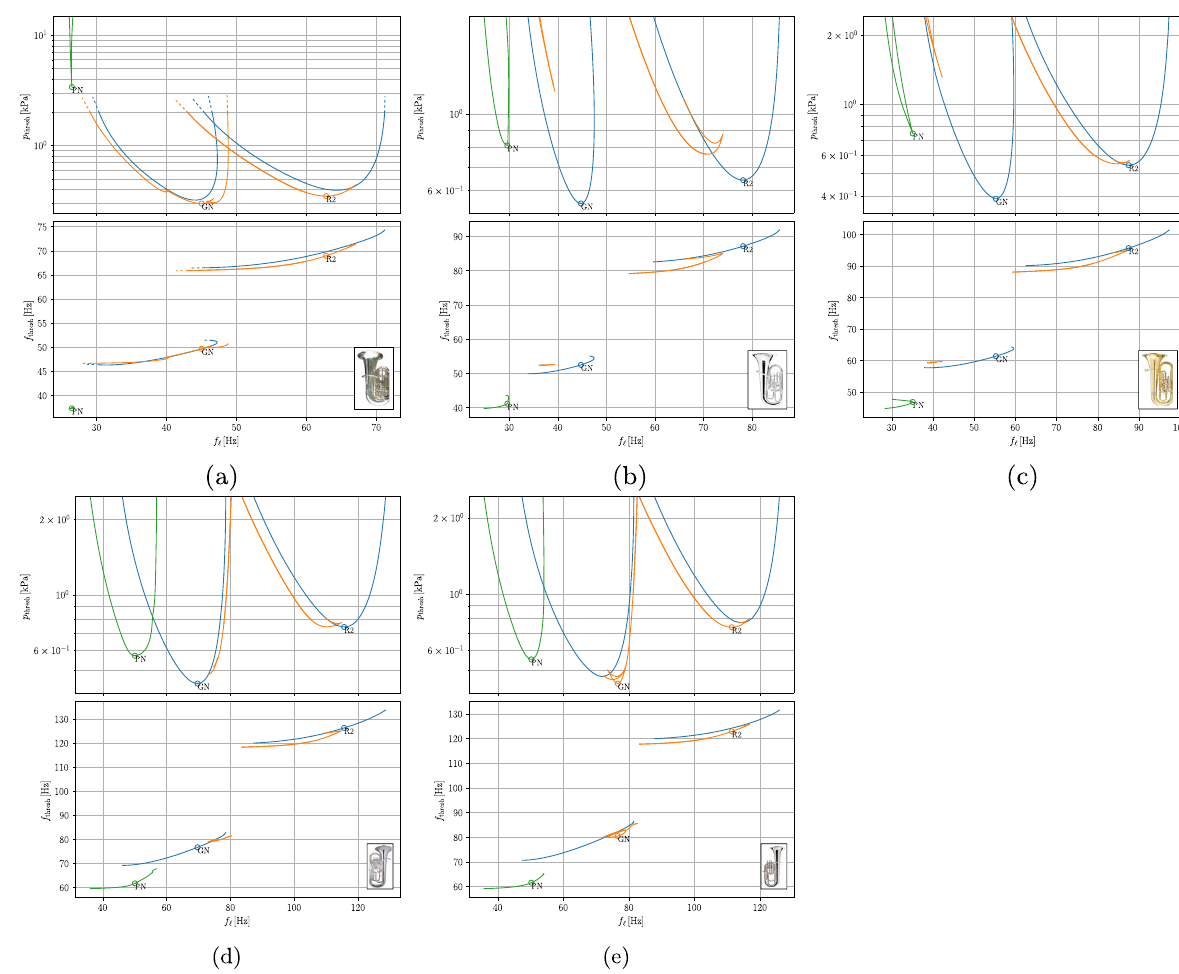
Figure A.1. Top and bottom plots represent respectively the threshold pressures and threshold frequencies given by the locus of the Hopf points (blue) and the locus of the saddle-node bifurcation points (orange and green) with respect to the lips ’ resonance frequency in the case of the C-contrabass tuba, E [ -bass tuba, F-bass tuba, B [ -euphonium and B [ -bass saxhorn. The circles identify the local minimum of blowing pressure for each note, namely the pedal note (PN), the ghost note (GN), and the second regime (R2). The dashed portions at the ends of each U-shaped patterns in the case of the C-contrabass tuba mean that these curves still exist above p m = 2 kPa, but the computation was simply not performed above this value of mouth pressure. (a) C-contrabass tuba. (b) E tuba. (c) F-bass tuba. (d) B [ -euphonium. (e) B [ -bass